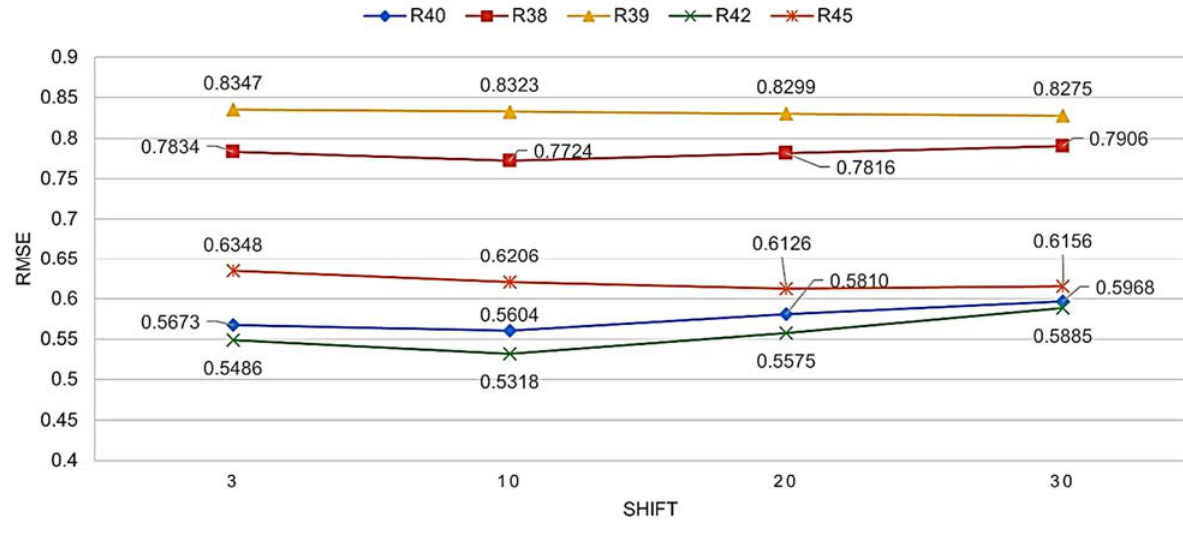
Figure 8. Average RMSE concerning shifts applied to outdoor temperature in predicting indoor temperature for validation set and 2 h prediction horizon.